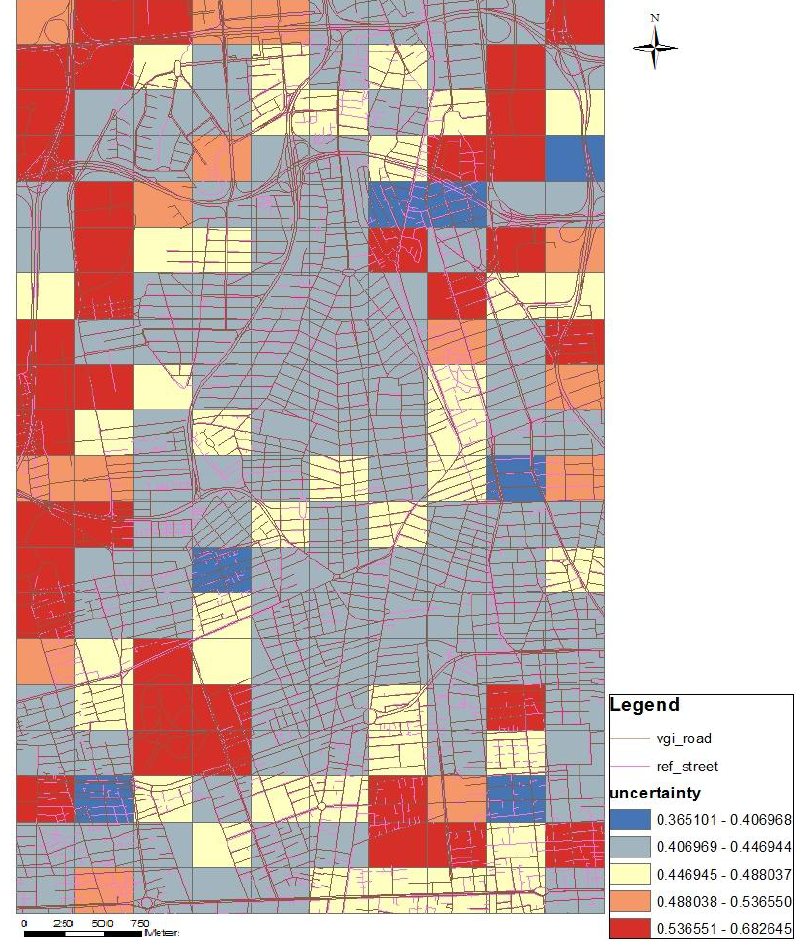
Figure 11. Evaluated uncertainty of the OSM dataset in comparison with that of the reference map on a tile-by-tile